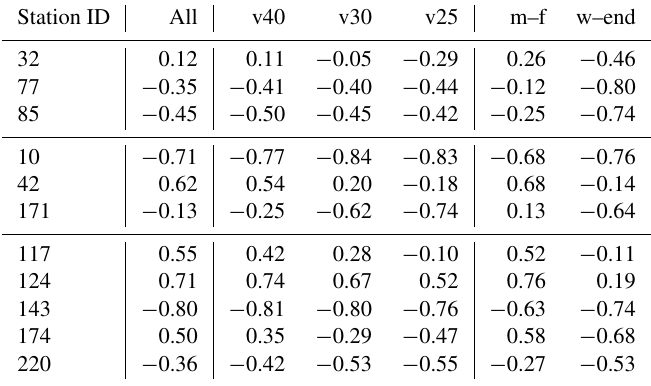
Table 3. Correlation coefficients R between medians of hourly MLH (derived from COBOLT) and PM 10 for different subsets of data. “All” indicates diurnal cycles based on 67 days as shown in Fig. 9 (second vertical line of each block). “v40”, “v30” and “v25” indicate only consideration of days with average wind speed v below 4.0, 3.0 and 2.5ms − 1 , respectively. “m–f” indicates Monday to Friday. “w–end” is the weekend only. The station IDs are according to Table 1. Station